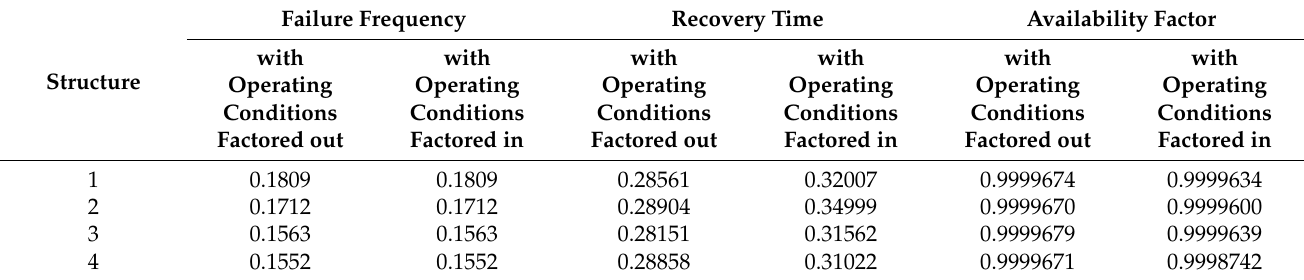
Table 3. System reliability metrics for different alternative structures of the distribution network.